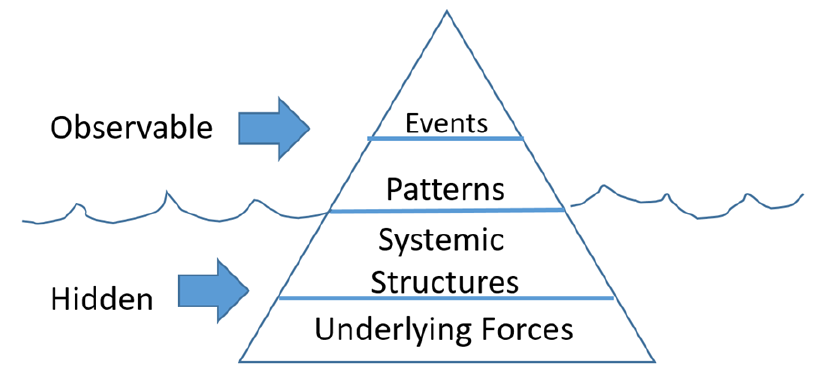
Fig. 4. The Iceberg